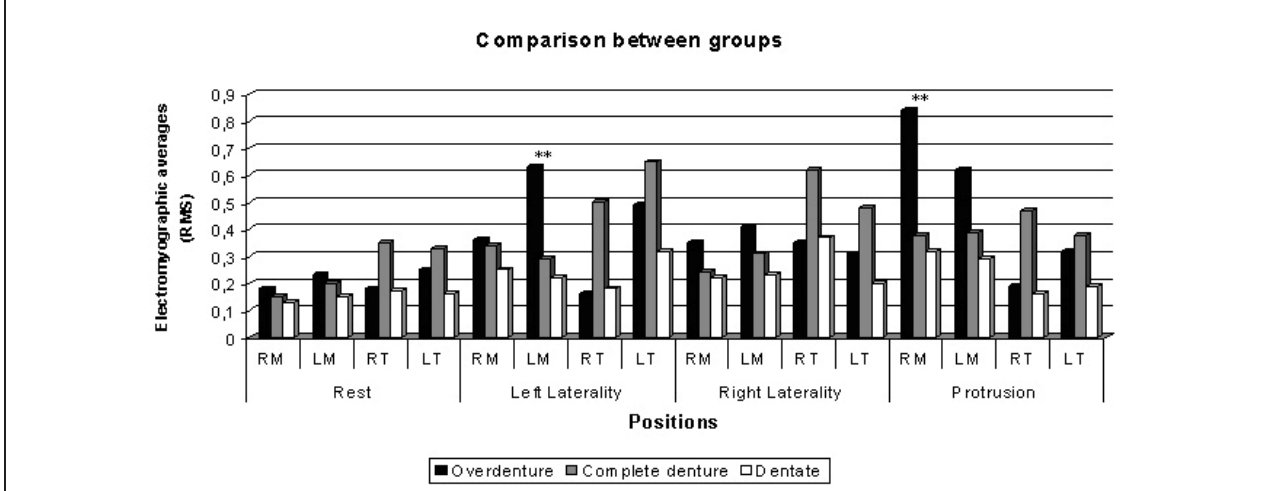
Fig. 1 - Normalized electromyographic averages (RMS) of the groups: overdenture wearers, complete denture wearers, and dentate individuals. Recordings of right masseter (RM) and left masseter muscles (LM), and right (RT) and left temporalis (LT); at rest, left laterality, right laterality and protrusion. ** Statistically significant if pd”0.01.